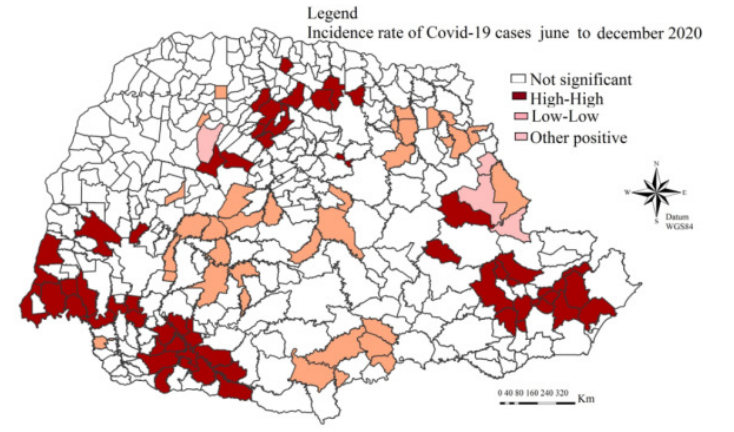
Figure 3. Clustering map of the incidence rate of confirmed cases of the new coronavirus by munici- palities in Paraná from June 2020 to December 2020, using the Moran local index (LISA).